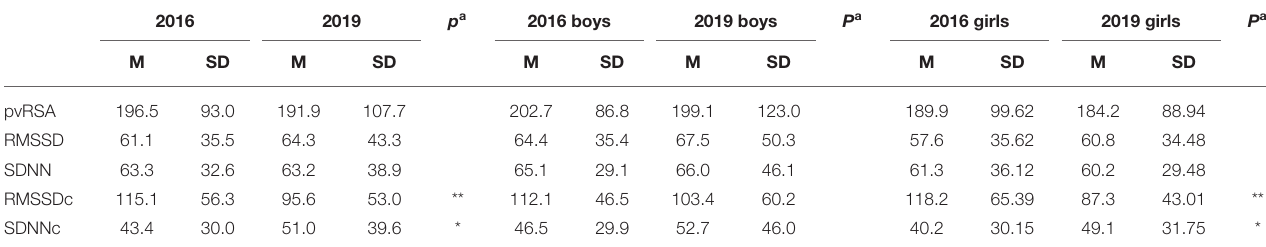
TABLE 2 | RSA indices at both visits.